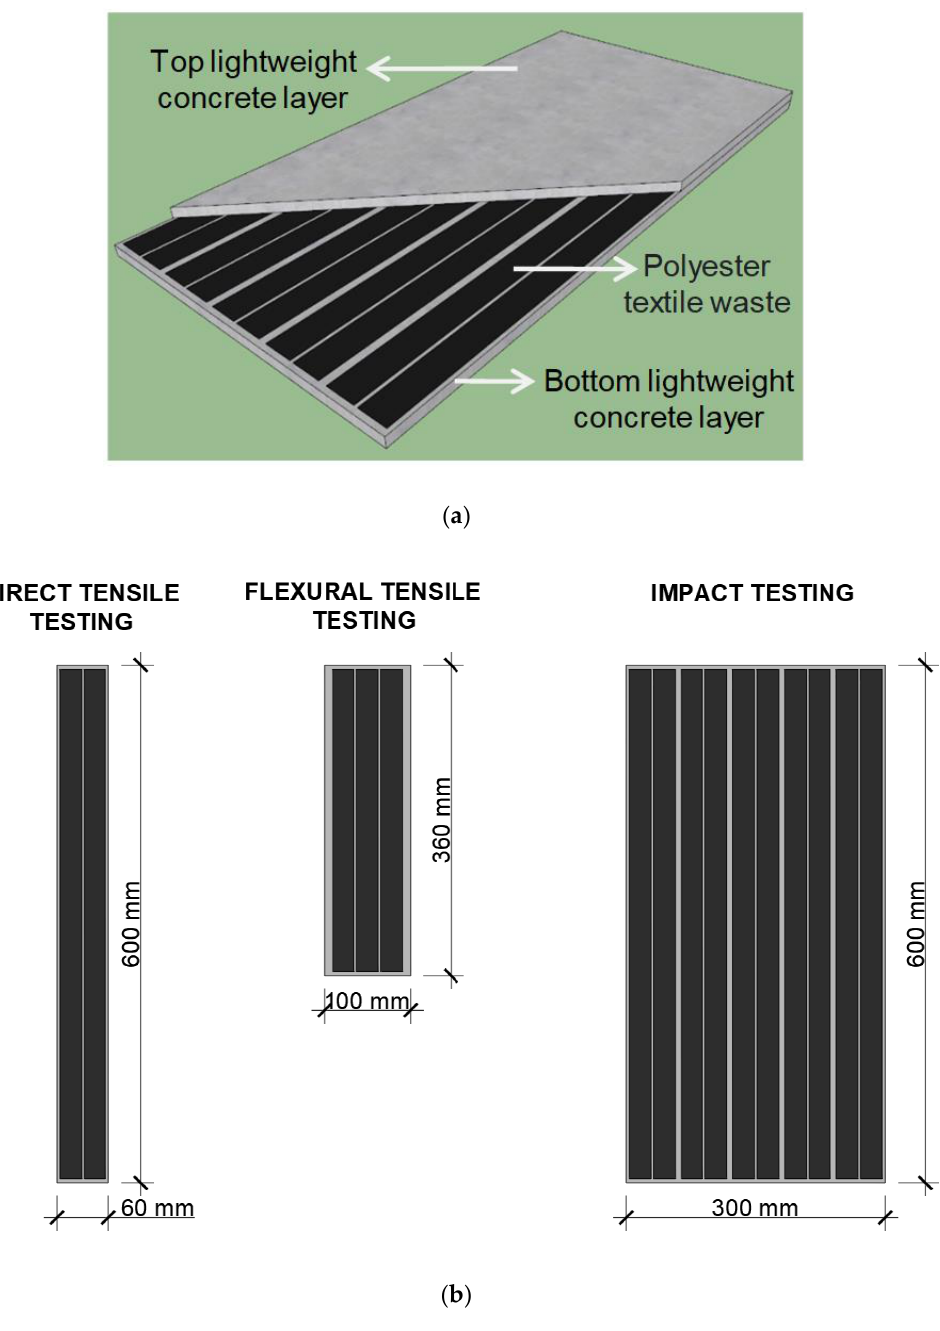
Figure 2. ( a ) 3D schematic of the layers of the composite; ( b ) dimensions and placement of textile reinforcements and test body sizes for each mechanical performance test.